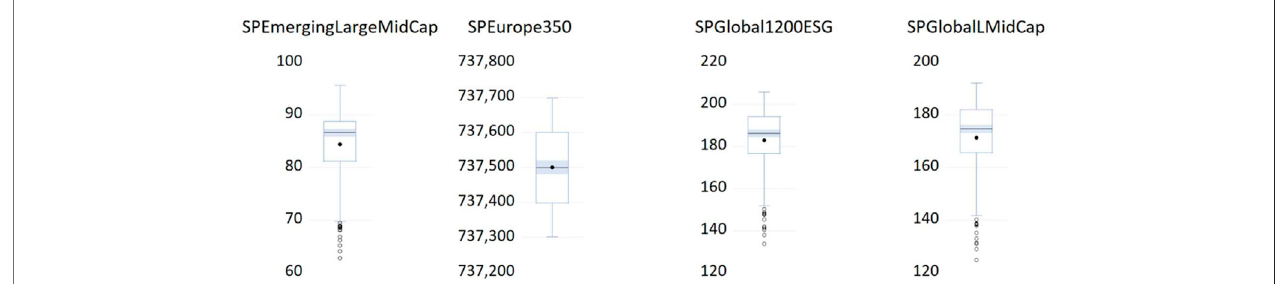
FIGURE 2 | Dynamics of ESG indices, data source Bloomberg.